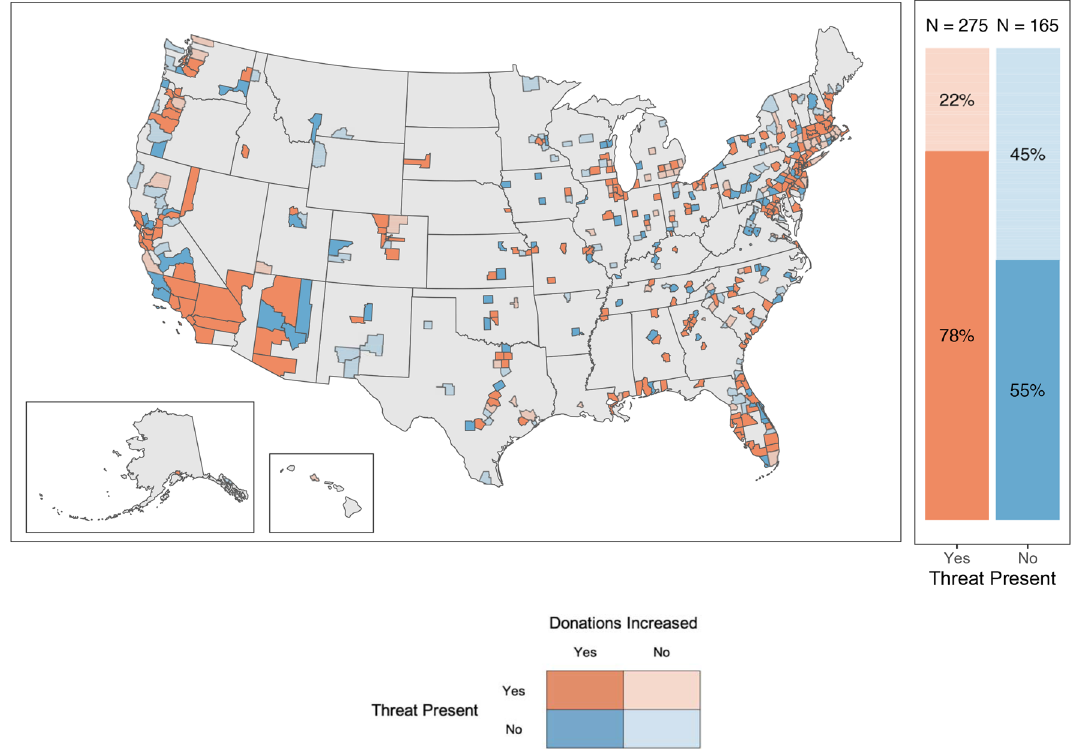
Figure 1. Counties by COVID-19 threat and donation changes—March 2019 versus March 2020. Orange [blue] represents the presence [absence] of threat in March 2020. Darker [lighter] shades indicate an increase [decrease] in giving across all charity categories relative to March 2019. The map shows U.S. counties with inset maps for counties in Alaska and Hawaii. The chart on the right shows the proportion of counties in each “threat present” and “donations increased”